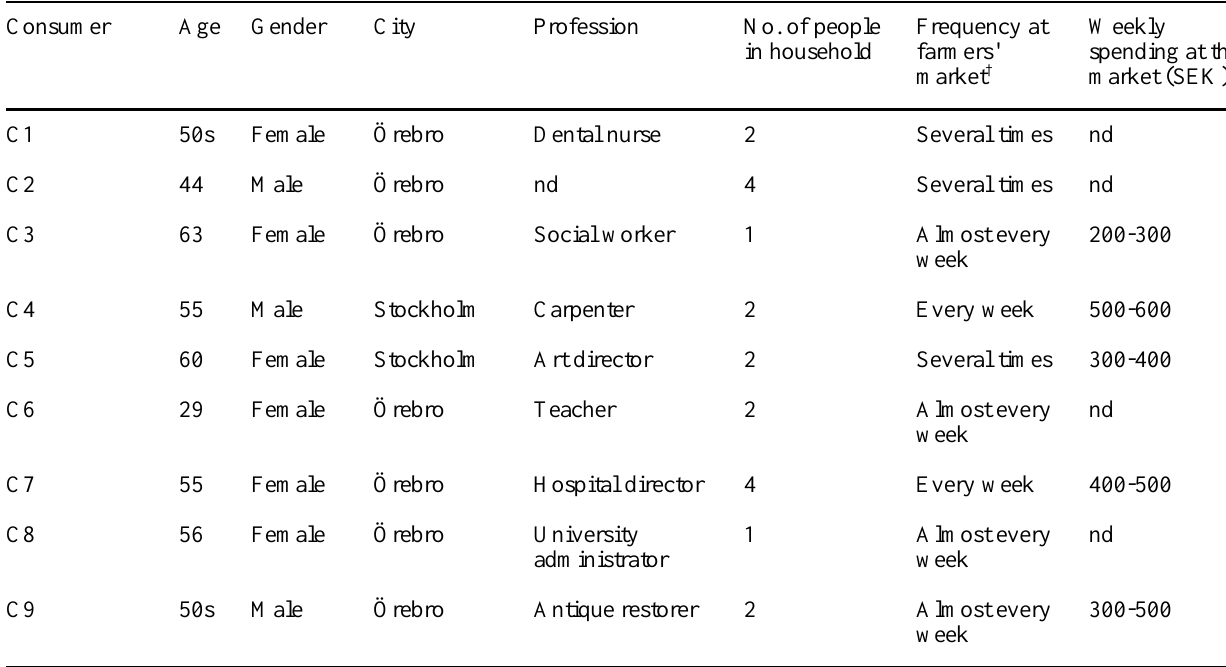
Table 2 . Descriptions of the customers interviewed in the